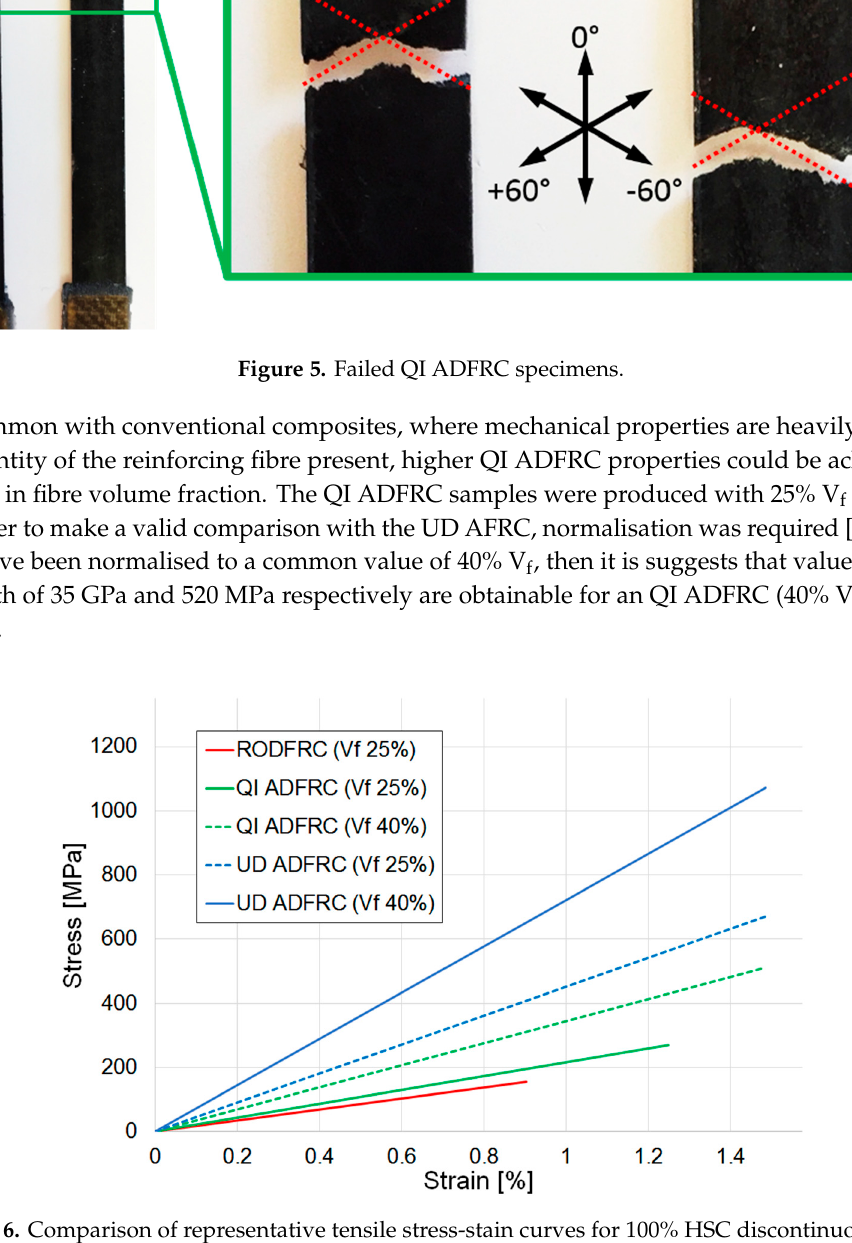
Figure 6. Comparison of representative tensile stress-stain curves for 100% HSC discontinuous fibre composites normalised to common V f values.